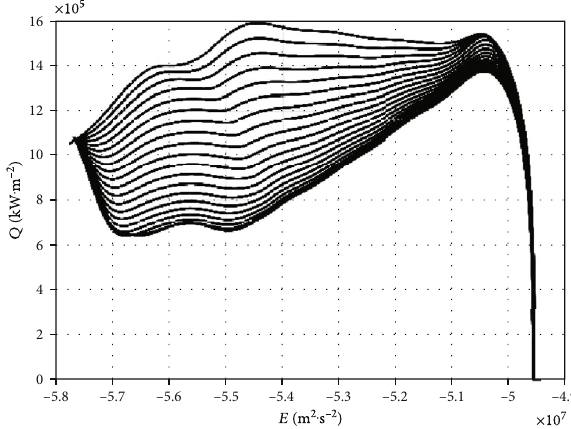
Figure 28: Heating rate pro fi les for Case